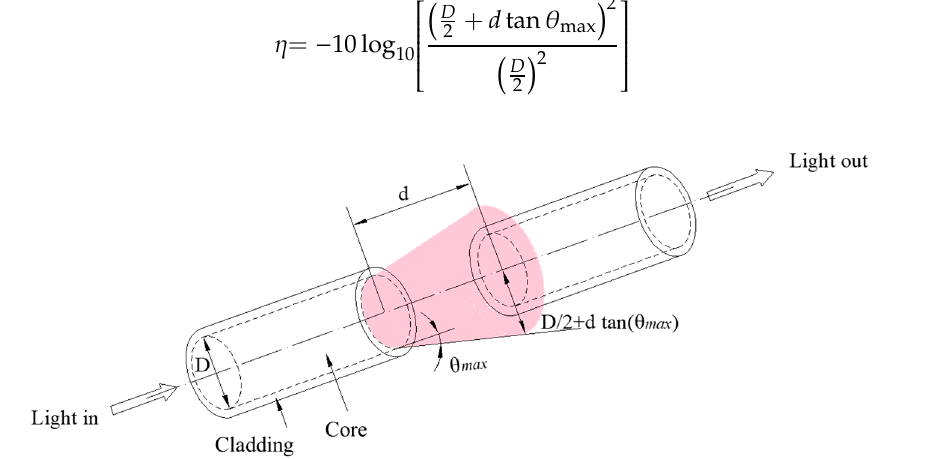
Figure 3. The schematic diagram of the sensing principle.